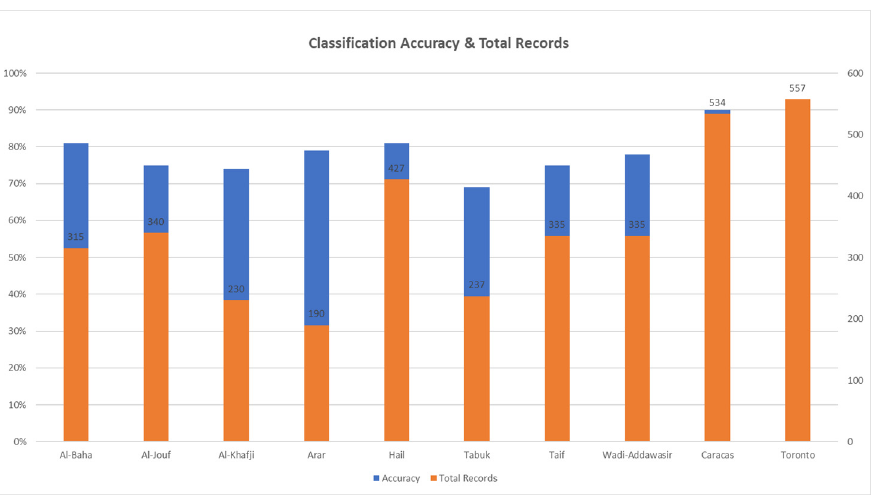
Figure 34. Classification accuracy of model prediction engine based on location with total records.